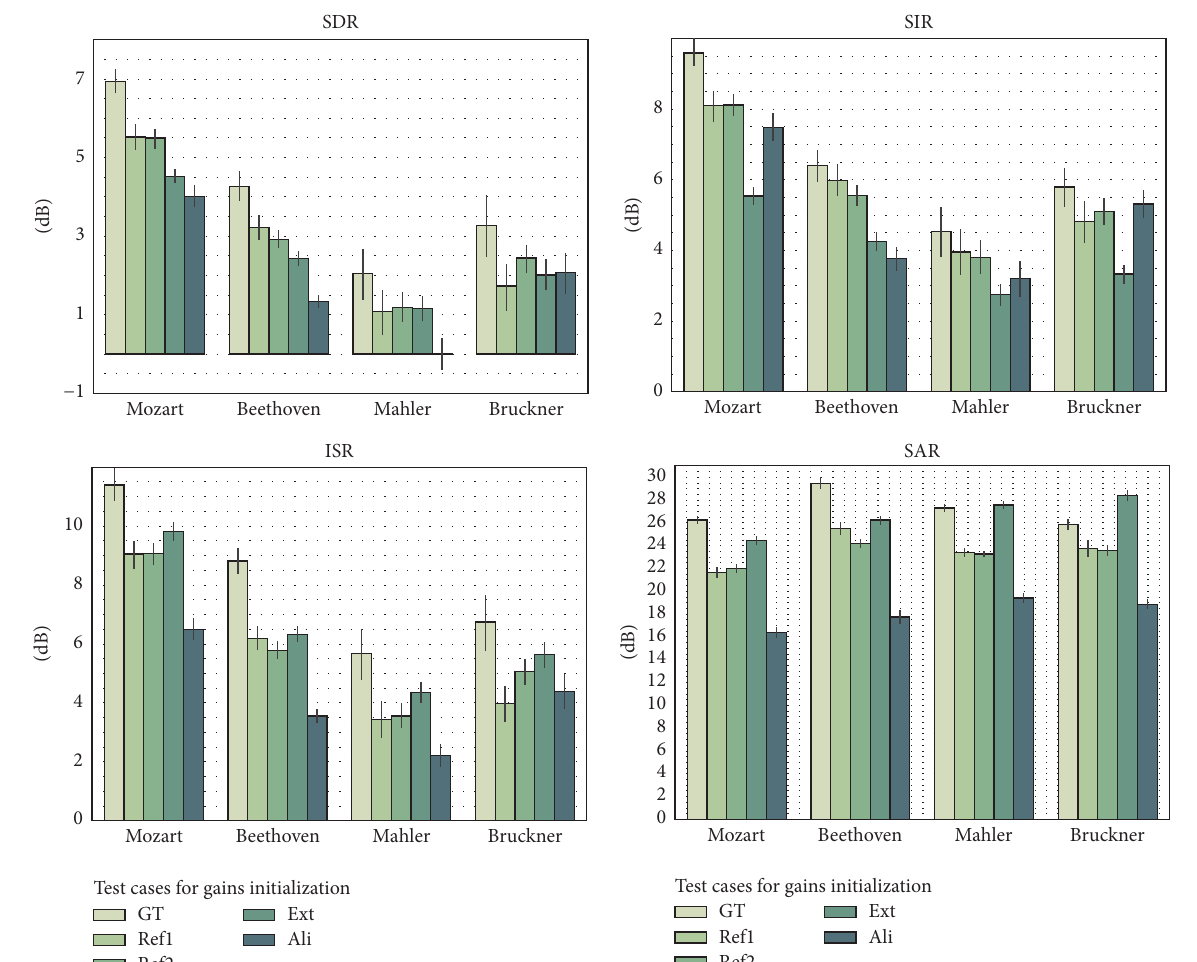
Figure 8: Results in terms of SDR, SIR, AR, and ISR for the NMF gains initialization in different test